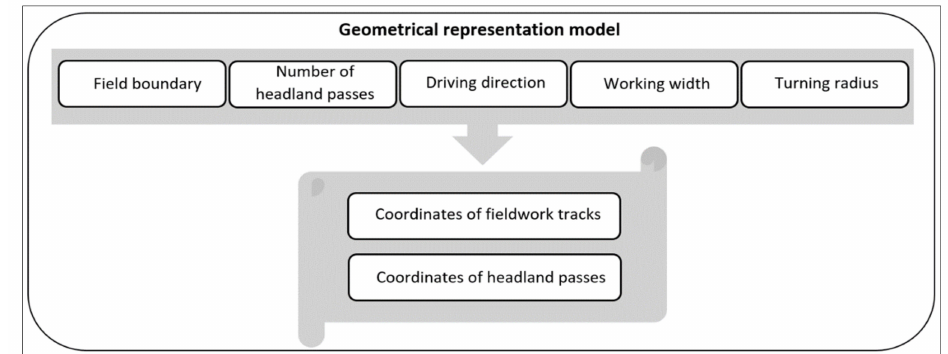
Figure 2. Geometrical representation model.